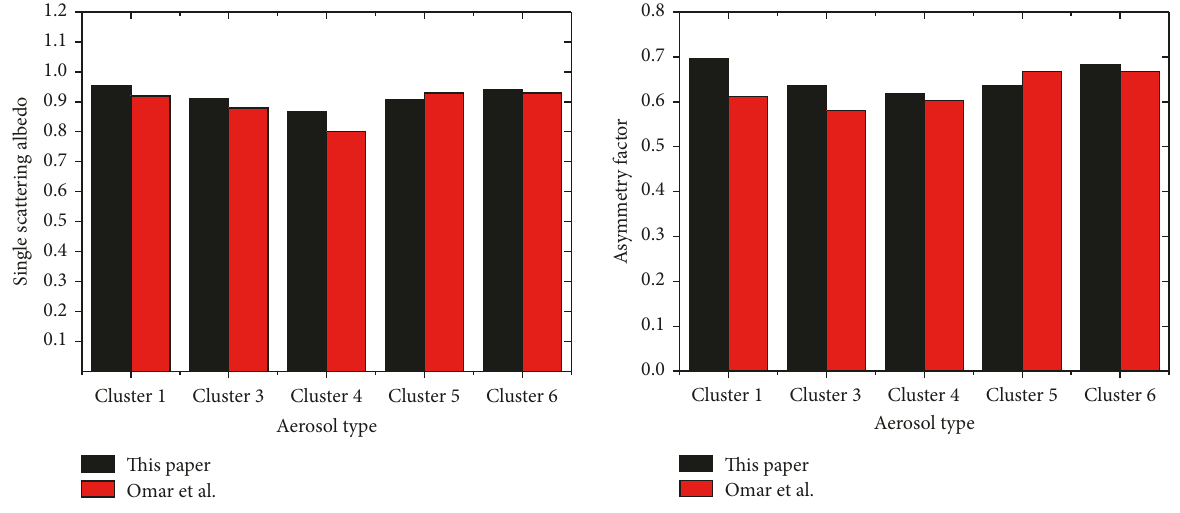
Figure 7: SSA and ASYM comparison with global aerosol types. Table 4: Characteristics of East Asian aerosol types by Lee et al.